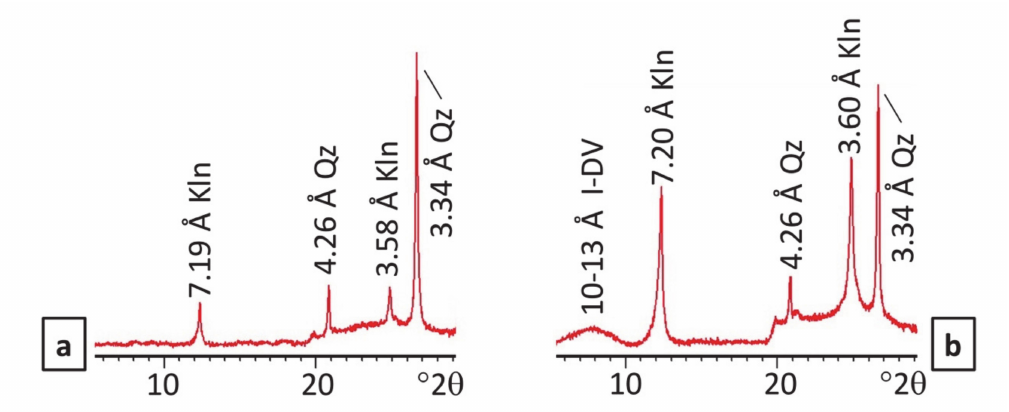
Figure 2. Representative di ff ractograms of oriented aggregates ( < 2 µ m fraction) from sediments of the UCRB sediments. ( a ) Sediments from the northeastern part of the basin. ( b ) Sediments from the La Playa